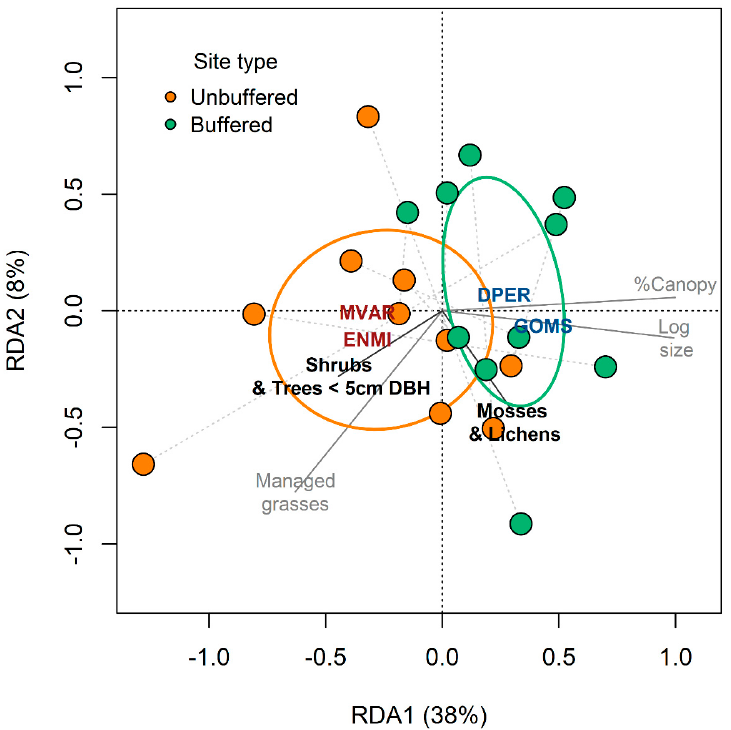
Figure 4. Partial redundancy analysis (pRDA) of diatom communities at site pairs revealed the influence of riparian attributes after conditioning out confounding spatial and environmental factors. Riparian attributes used in the pRDA are shown in black. We also correlated additional riparian attributes that intuitively are associated with forested riparian bu ff ers and unbu ff ered, upstream reaches (‘envfit’; Log size, R 2 = 28.7%, p < 0.05; % Canopy cover, R 2 = 10.4%, p = 0.391; and % Managed grasses, R 2 = 24.9%, p = 0.084). Indicator diatom species for unbu ff ered sites were Encyonema minutum (ENMI) and Melosira varians (MVAR), whereas Humidophila perpusilla (DPER, in OMNIDIA as Diadesmis perpusilla ) and Gomphonema spp. (GOMS) were characteristic of bu ff ered